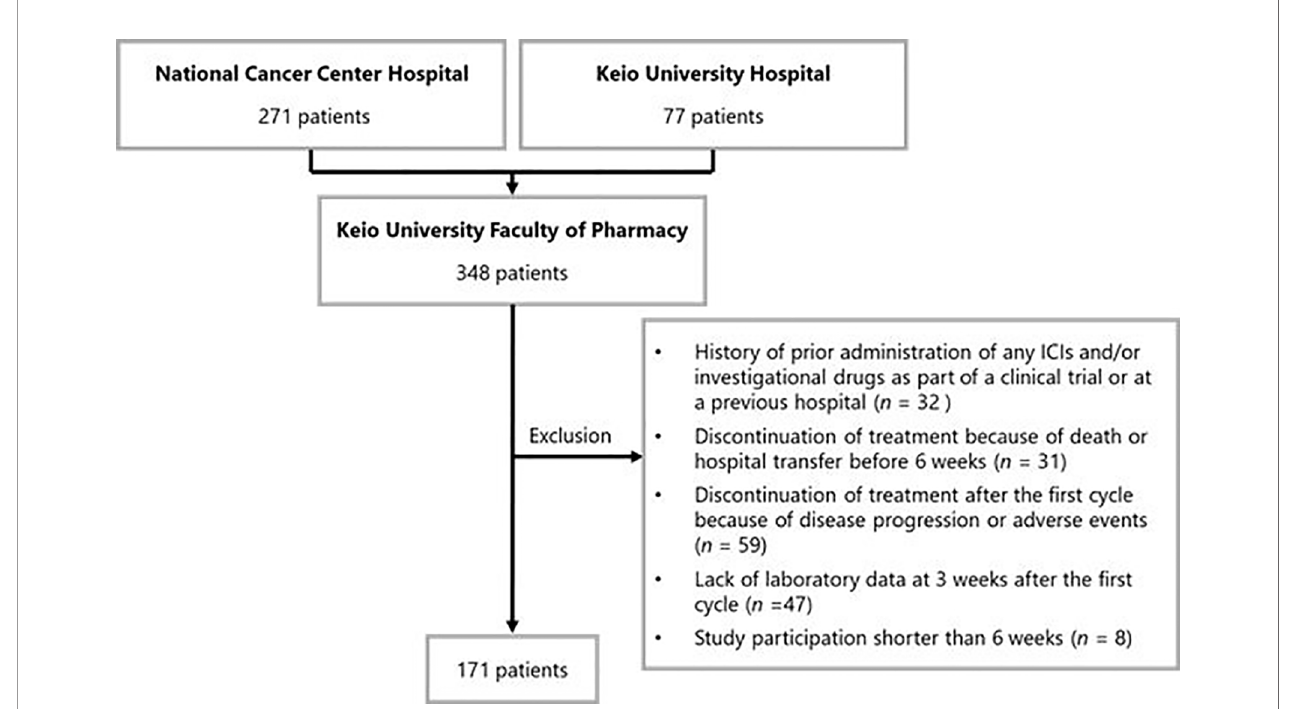
FIGURE 1 | Patient enrollment fl owchart. ICI, immune checkpoint inhibitor.